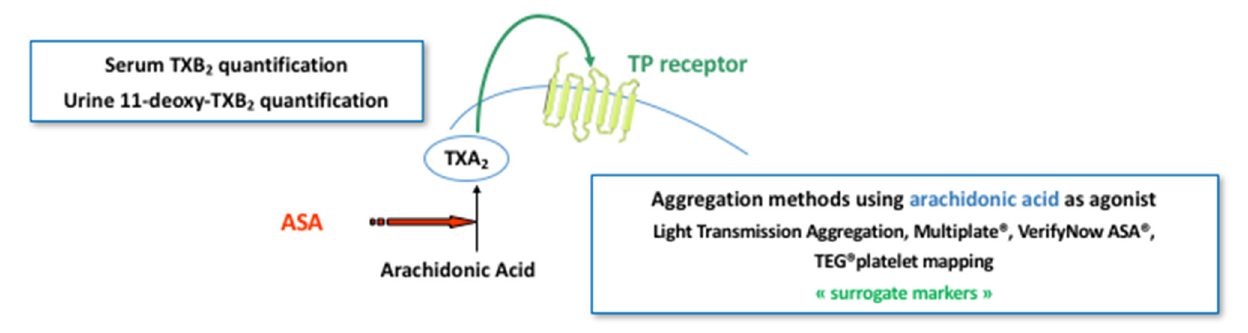
Frontiers in Cardiovascular Medicine |